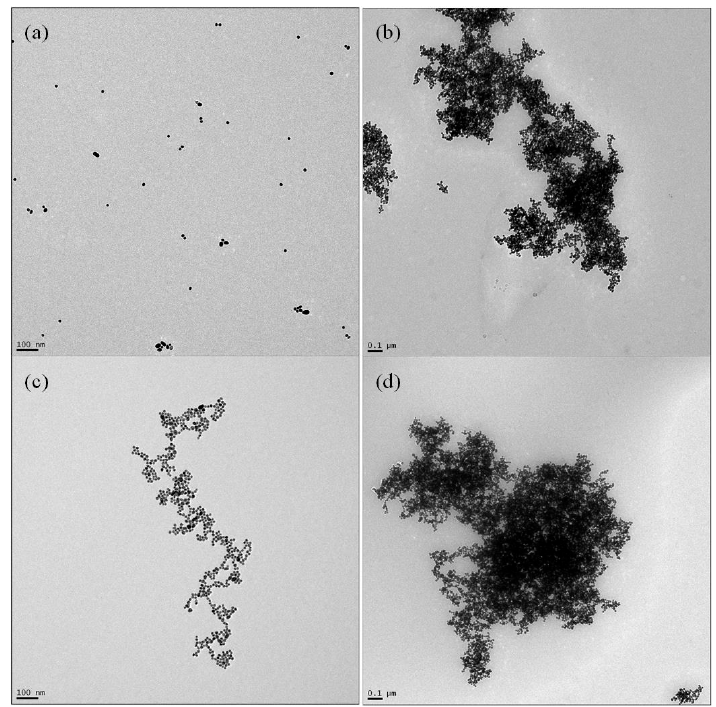
Figure 5. TEM images of the following: ( a ) untreated AuNP, ( b ) AuNP + 280 mM NaCl, ( c ) AuNP + 1µM GA + 280 mM NaCl, ( d ) AuNP + 1µM GA + 1500 nM gentamicin + 280 mM NaCl. Varying concentrations of gentamicin from 0–3000 nM were examined spectroscopi- cally using a microplate (Figure 6a) and its corresponding color change is depicted in Fig- ure 6b.